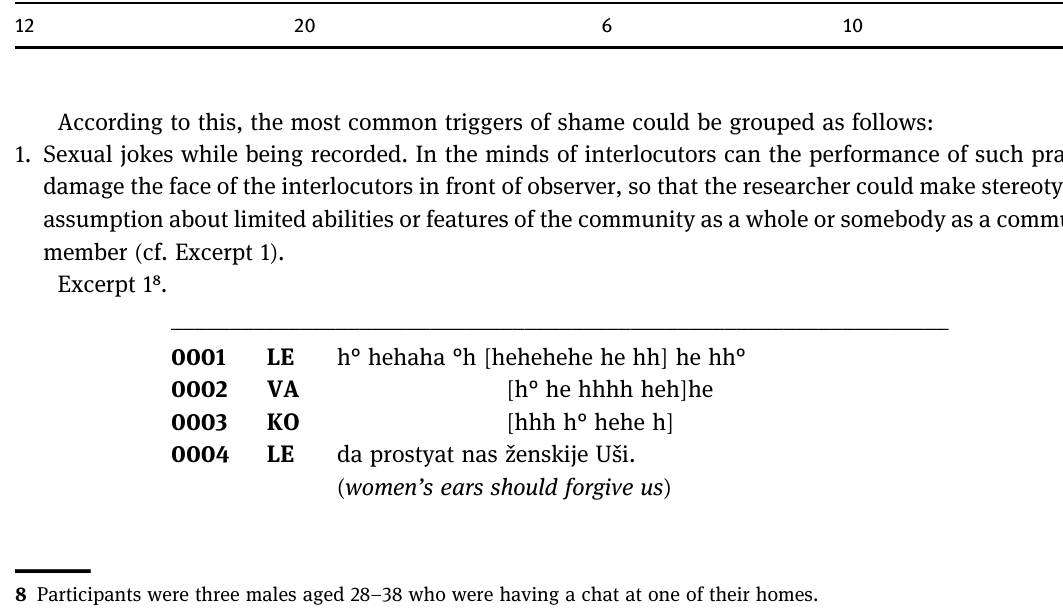
Individual experiences of embarrassment without public